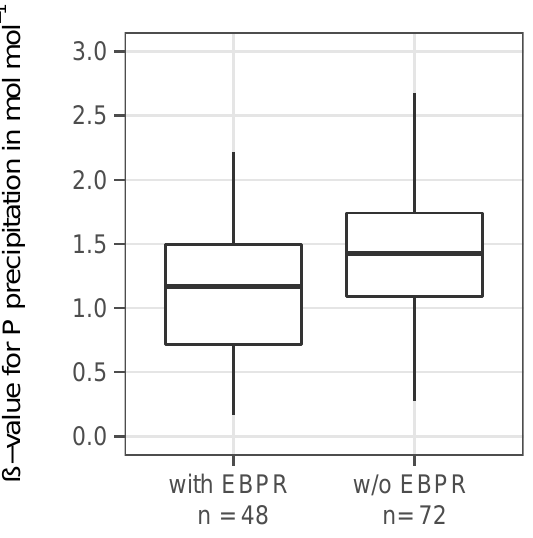
Figure 1. Comparison of ß-values for P-precipitation with and without additional enhanced biological phosphorus removal (EBPR) in mol precipitation agent per mol P. Statistical values are provided in Table S2.